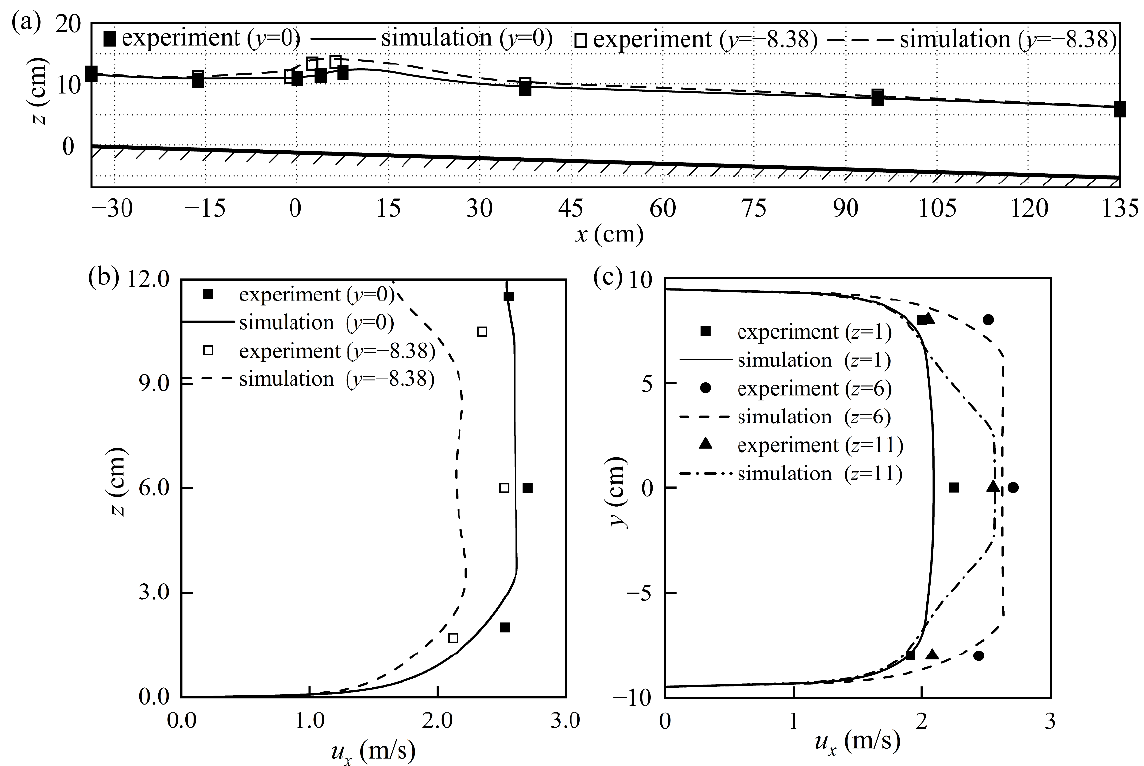
Figure 3. Comparison of the experimental and numerical results: ( a ) water surface profile; ( b ) vertical; and ( c ) horizontal distribution of the streamwise velocity u x at x = 112.5 cm. The unit of the coordinates is cm.